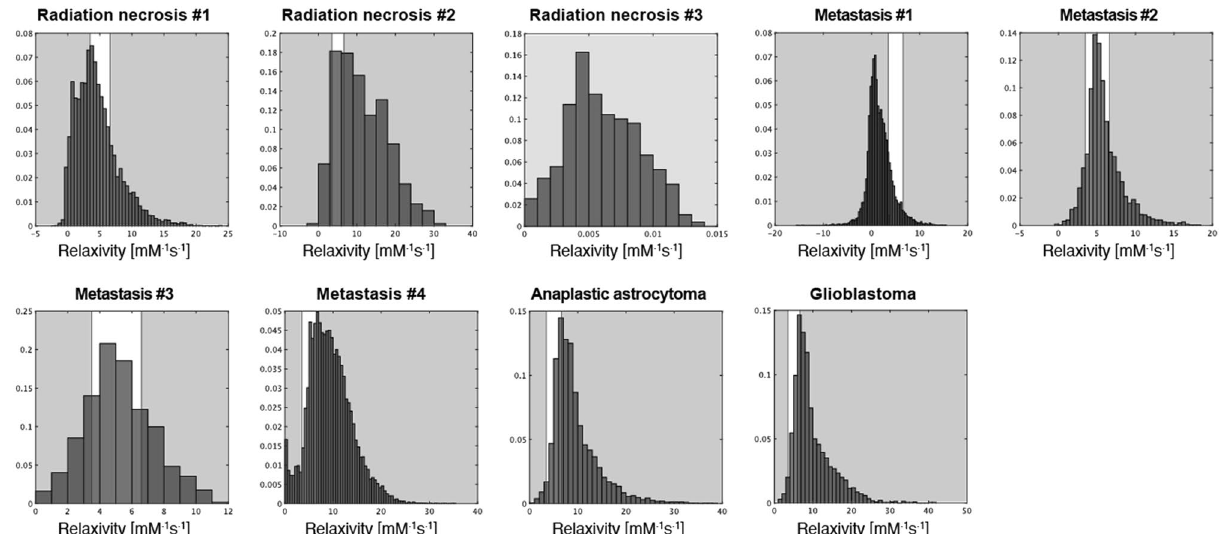
Figure 8. Histogram of relaxivity in the tumor lesion for each patient. White and gray areas indicate pH sensitive and insensitive ranges against the relaxivity distribution,